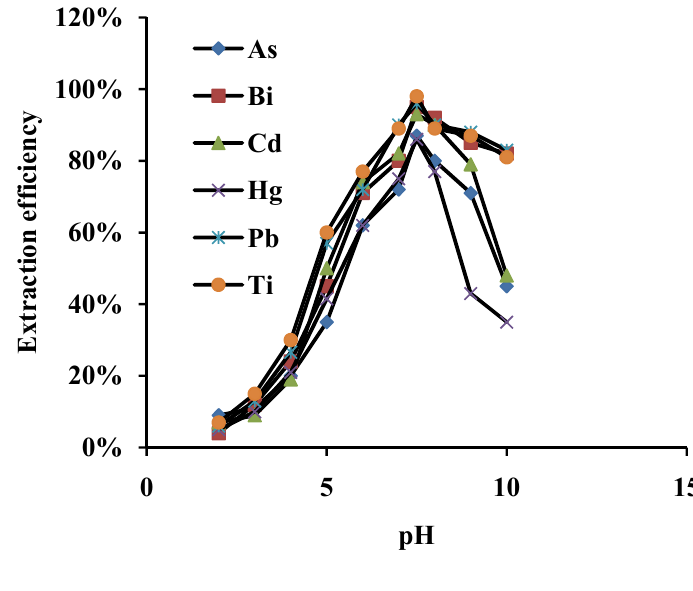
Figure 1. Effect of pH on the adsorption of As, Bi, Cd, Hg, Pb and Ti onto MWCNTs. Concentration of studied ions: 0.1 µg·mL − 1 (N =